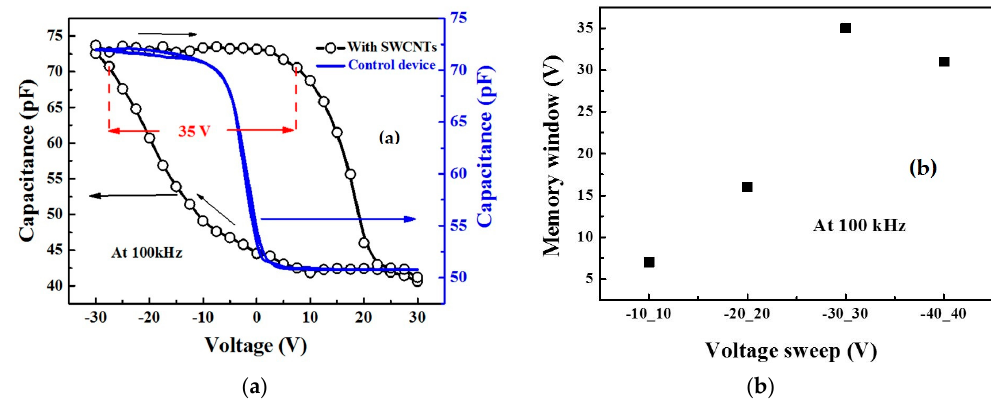
Figure 2. ( a ) C – V characteristics at 100 kHz for the SWCNTs-based metal–insulator–semiconductor (MIS) memory (open circle and line) and control (blue solid line) devices and ( b ) the memory window (flat–band voltage shift) versus voltage sweep range.